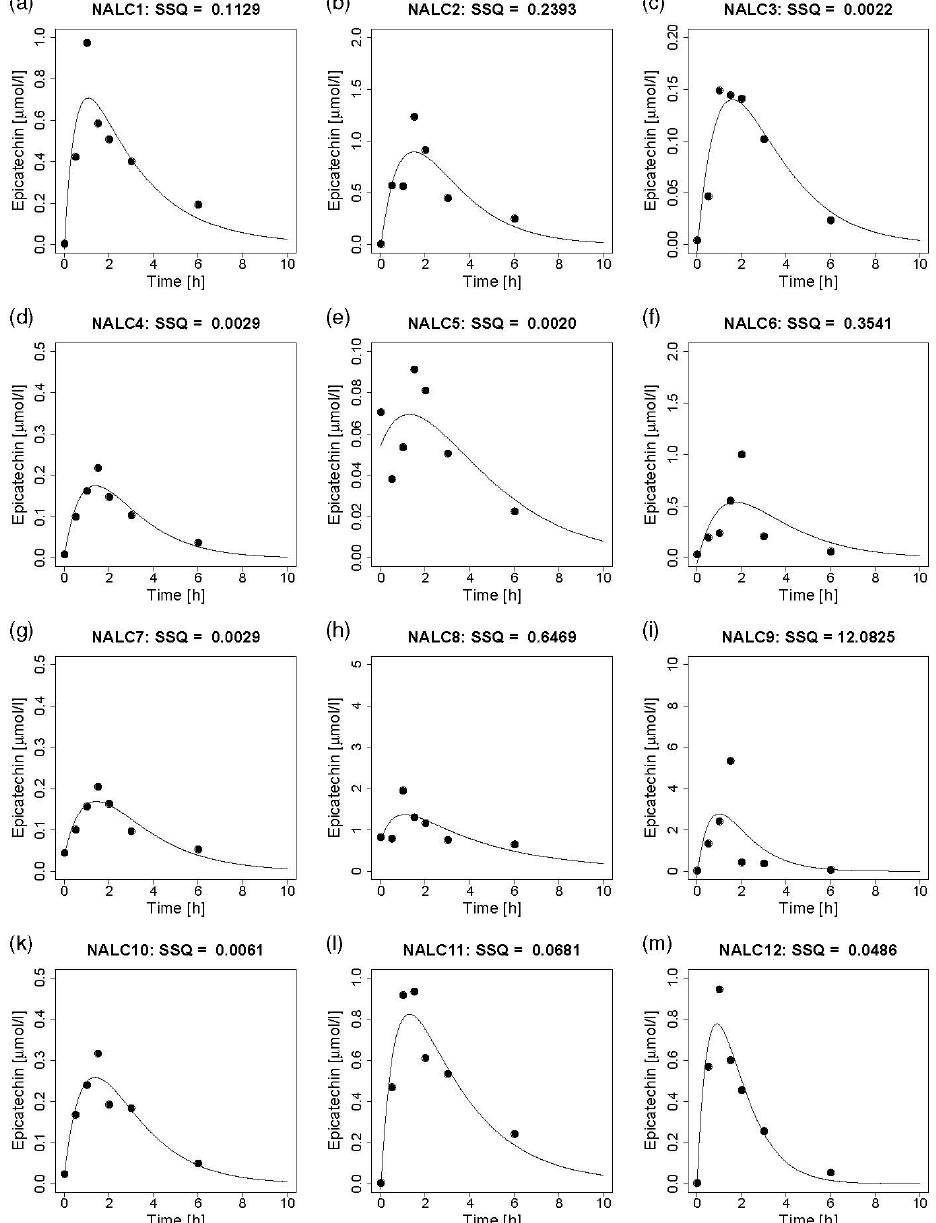
Figure 1. Individual epicatechin concentration time curves obtained after consumption of a beverage prepared with nonalkalized cocoa. Each panel ( a – m ) represents one participant. The dots represent the measured values. The curves reflect the predicted concentrations in plasma within 10 h after ingestion of nonalkalized cocoa, based on the one-compartment model. NALC, nonalkalized cocoa; SSQ, sum of squares of residuals. Note the di ff erent scaling of the